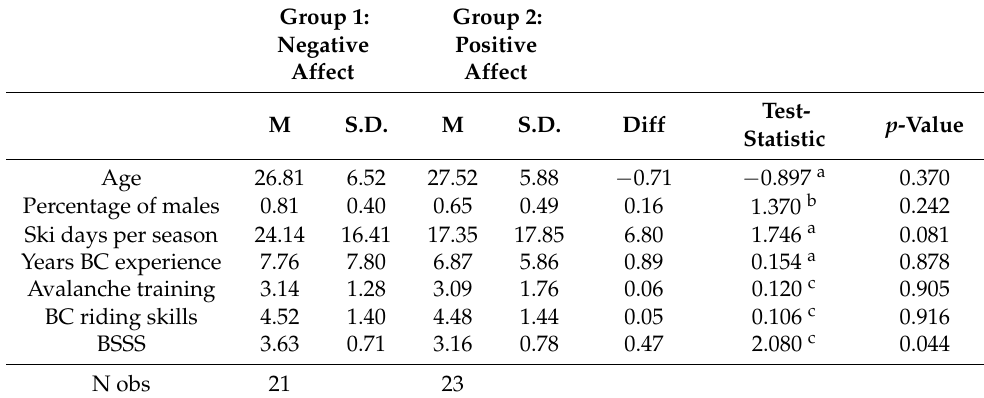
Table 1. Descriptive